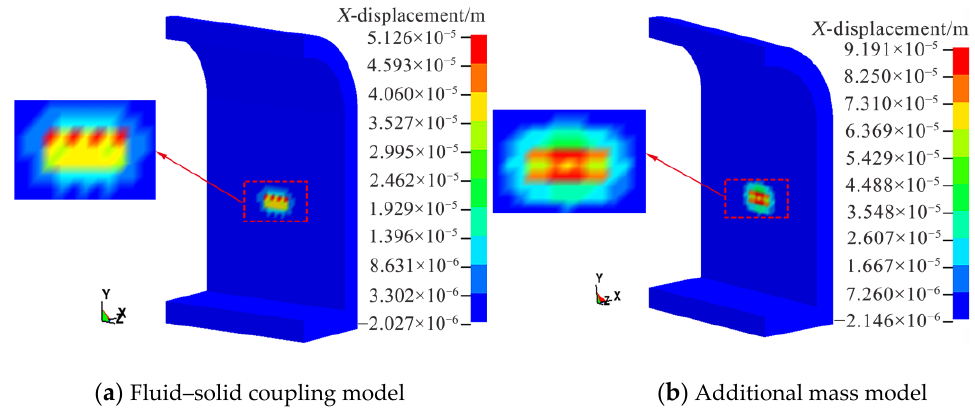
Figure 6. Displacement clouds in X -direction under different collision models, where: Local enlargement of the ice−tunnel impact zone is performed